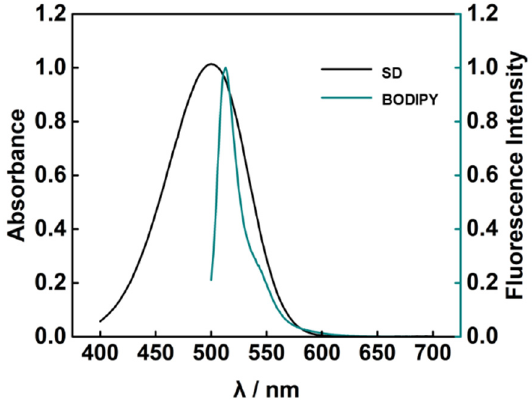
Figure 2. The overlay of the normalized fluorescence emission spectrum of BODIPY (excitation: 480 nm) and the absorption spectrum of SD.